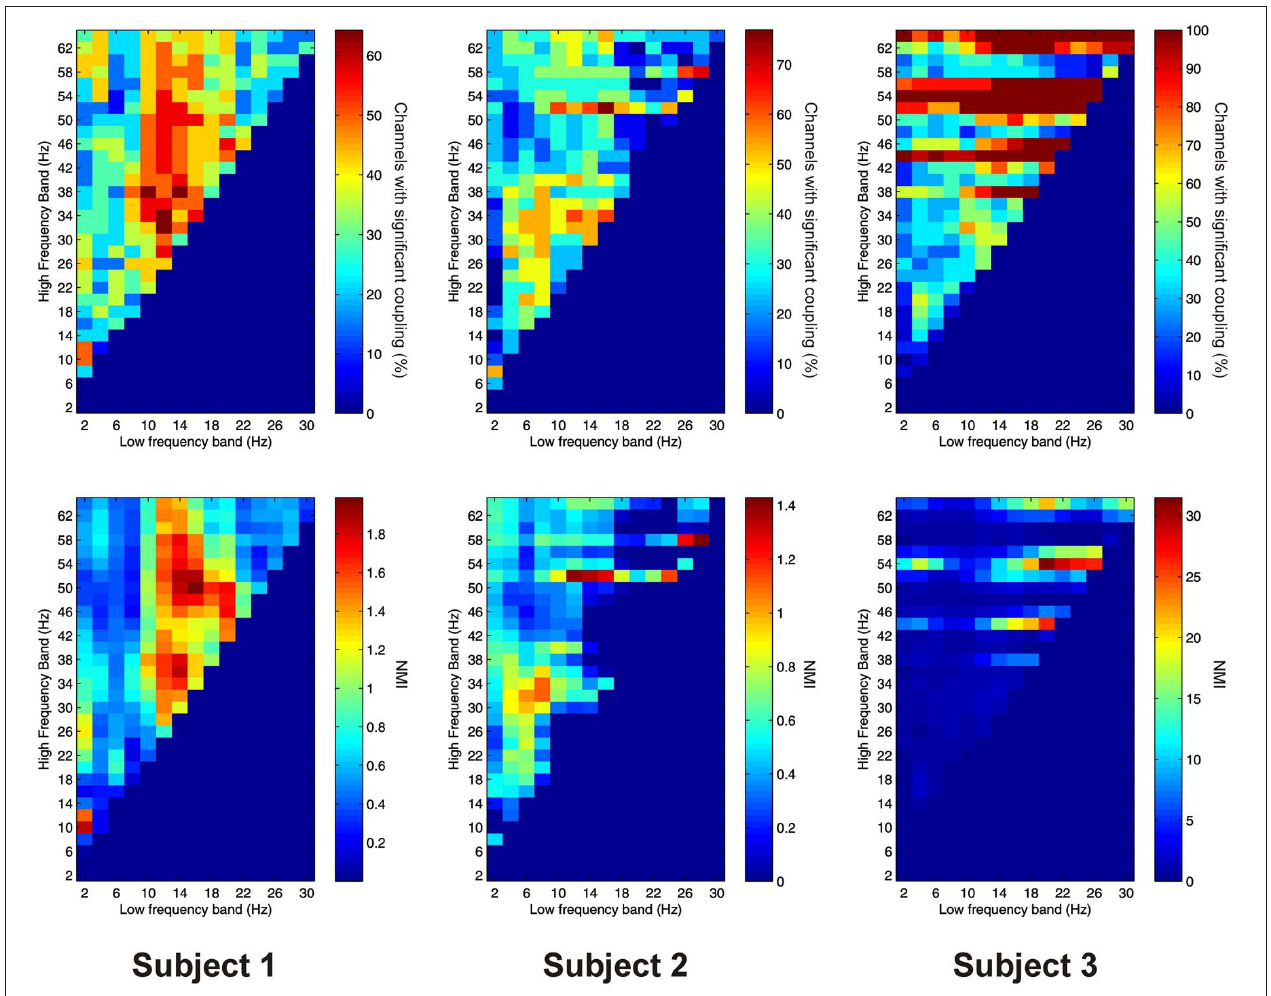
FIGURE 4 | Top row: Proportion of channels showing significant local PAC in the PFC (Subject 1 left, Subject 2 middle, Subject 3 right). Bottom row: Mean strength of PAC (assessed with the normalized modulation index) in the PFC (Subject 1 left, Subject 2 middle, Subject 3 right).